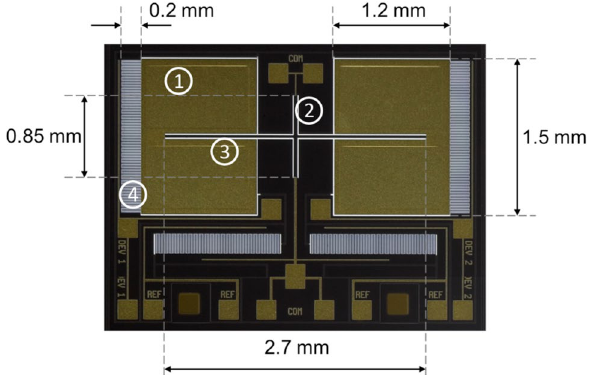
Figure 1. Optical micrograph of the tested MEMS sensor. ➀ Wing—main movable surface due to acoustic coupling. ➁ Leg—beam connecting the bridge and all freestanding membranes to the substrate; it also acts as a torsional spring. ➂ Bridge—beam connecting two opposite wings, mechanically coupling them. ➃ Interdigitated comb finger capacitors transduce wings’ mechanical displacements into capacitance